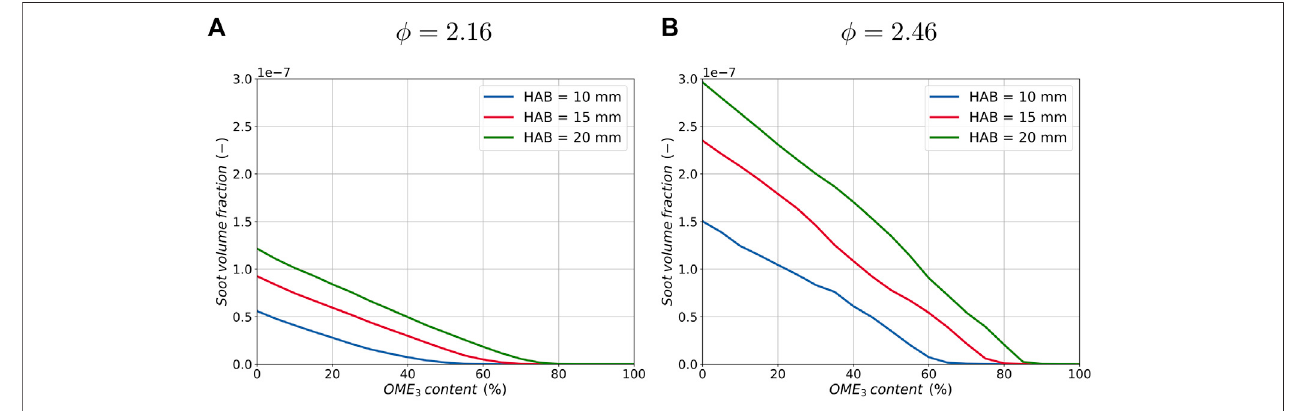
FIGURE6| CorrelationbetweensootvolumefractionandtheblendingratioofOME 3 forthreedifferentpositionsinthe fl ameandforanequivalenceratioof ϕ (cid:1) 2.16 (A) and ϕ (cid:1) 2.46 (B) .